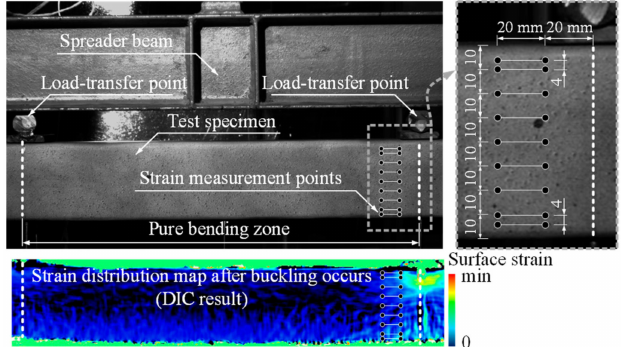
Figure 7. Virtual strain gauges of the DIC